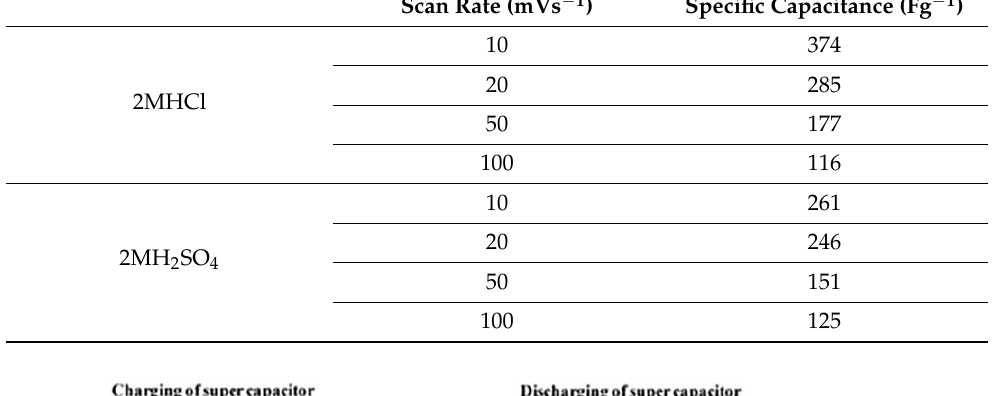
Table 1. Specific capacitance values of PEDOT/graphene nanocomposite in acidic systems, measured using CV studies [67]. PEDOT = poly(3,4-ethylenedioxythiophene). Reproduced with permission from Elsevier.